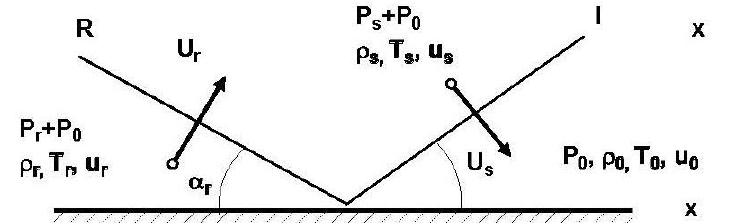
Figure 1. The reflection of a wavefront at the meeting of a rigid and infinitely long environment.